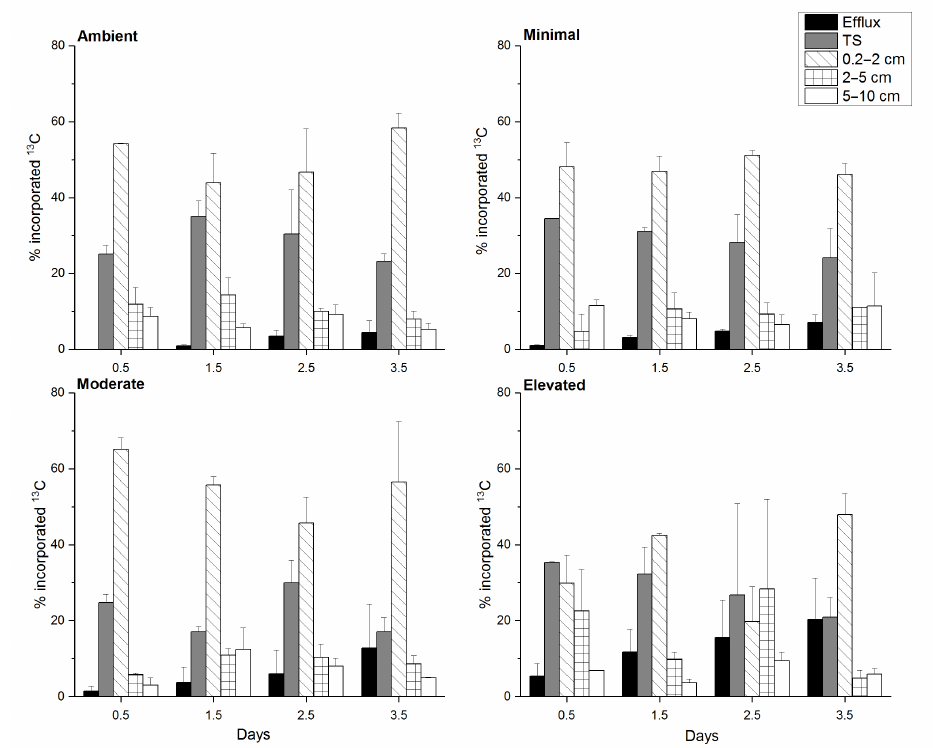
Figure 2. Carbon budget for excess 13 C within sediment OC at top scrape (TS), 0.2–2, 2–5, 5–10cm, and the cumulative excess 13 C exported to the water column via the combined efflux of DIC and DOC for each treatment at each sampling time. All values are as a percentage of the 13 C initially incorporated into sediment OC (0–10cm). Some error bars are too small to be seen (mean ±